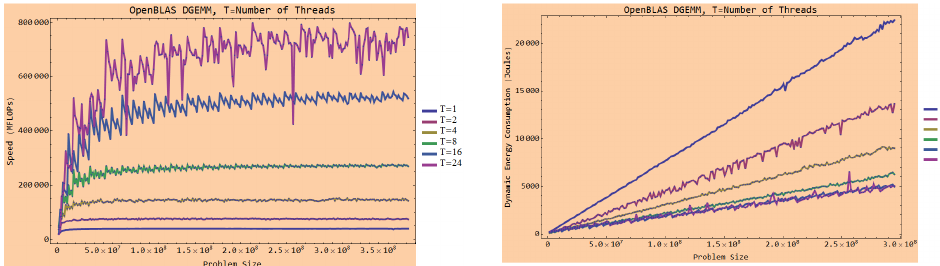
Figure 7. The speed (MFLOPs) and dynamic energy consumption profiles of OpenBLAS DGEMM application executing a varying number of threads ( T ) on the Intel Haswell server. The application multiplies two matrices of size x × n and n × n where n is 46,080. The problem size in the figure is x × n . The workload size 2 × x × n 2 is proportional to the problem size (since n is kept